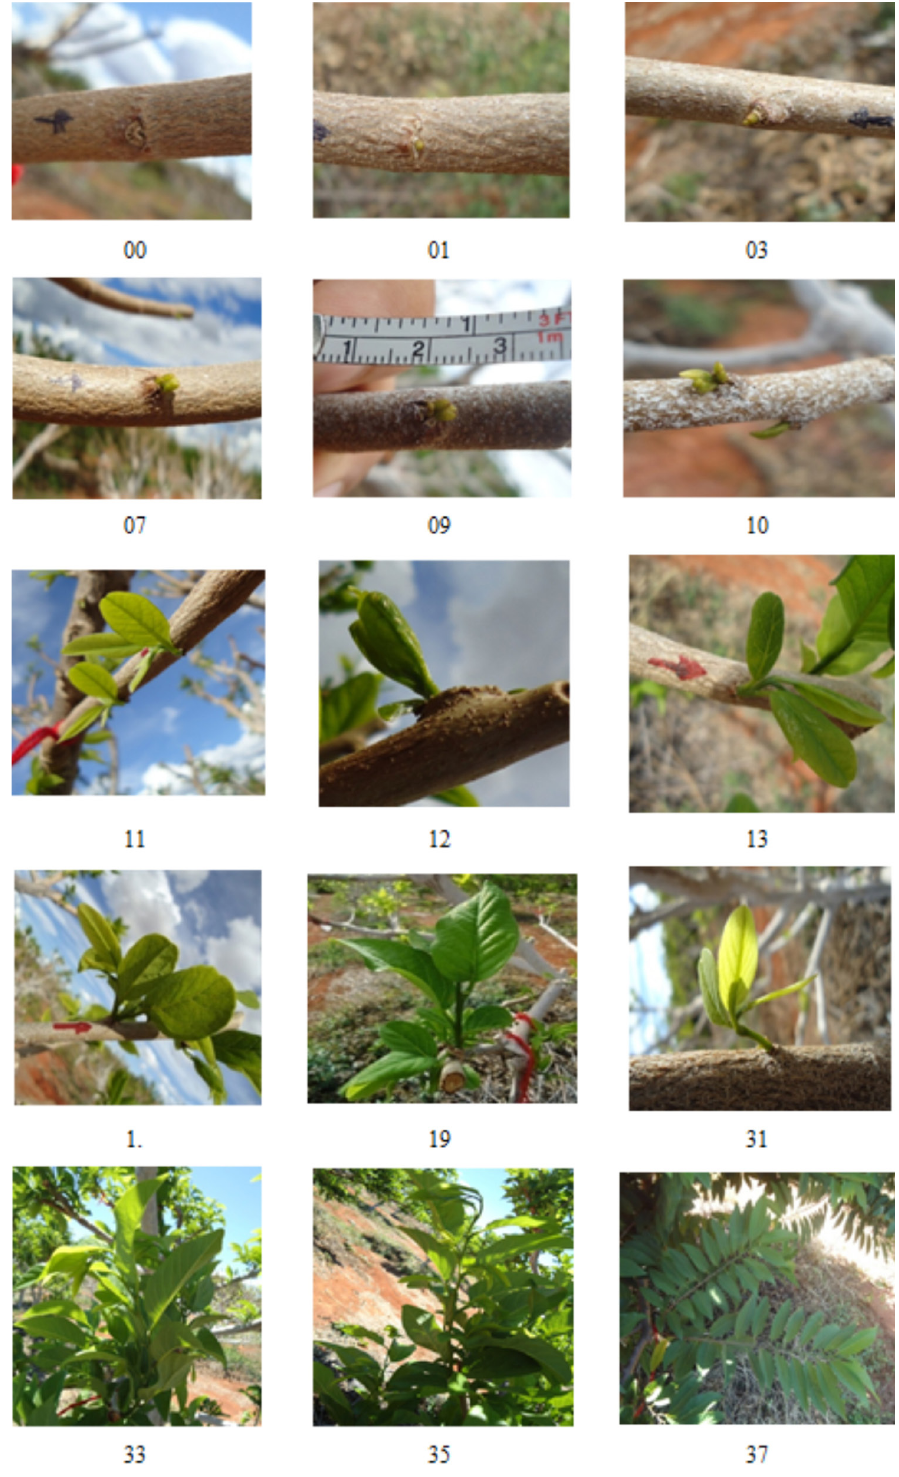
Figure 2 - Principal growth stages (00-37) of sugar-apple ( A. squamosa L.) as described by the BBCH scale in Janaúba, Minas Gerais,